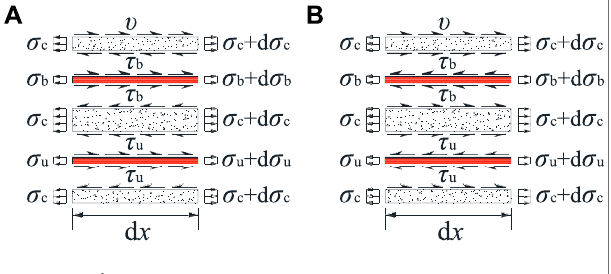
FIGURE 4 | Translational equilibrium of the sub-domain: (A) in the left part of a sub-element and (B) in the right part of a sub-element.